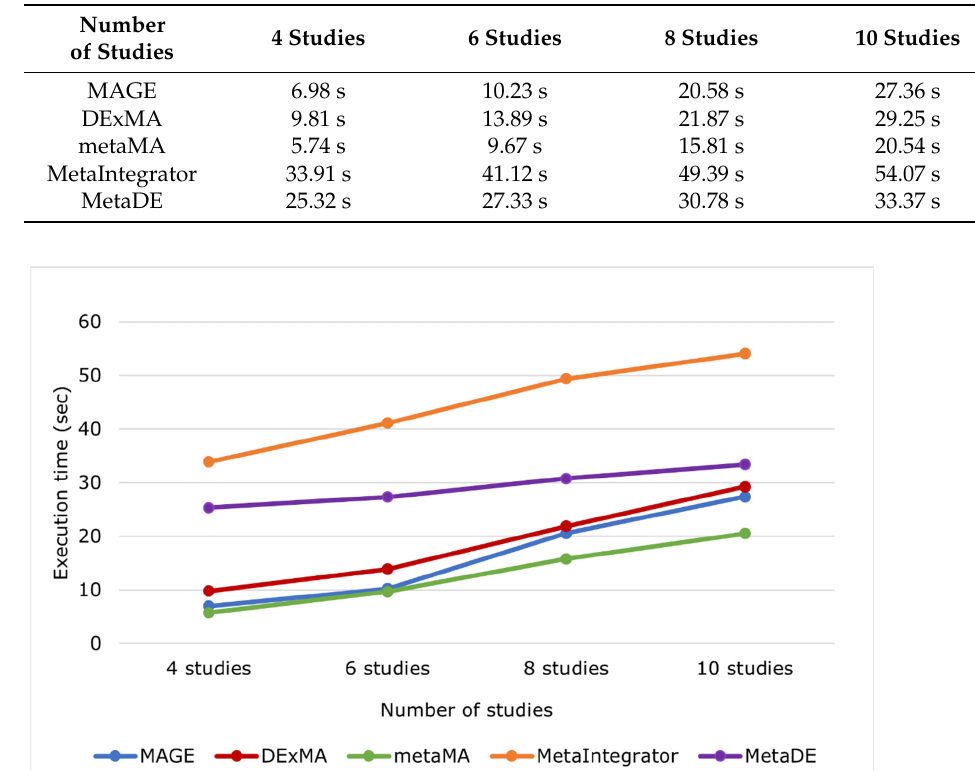
Table 2. Evaluation of MAGE and other tools in terms of speed with varying number of studies.